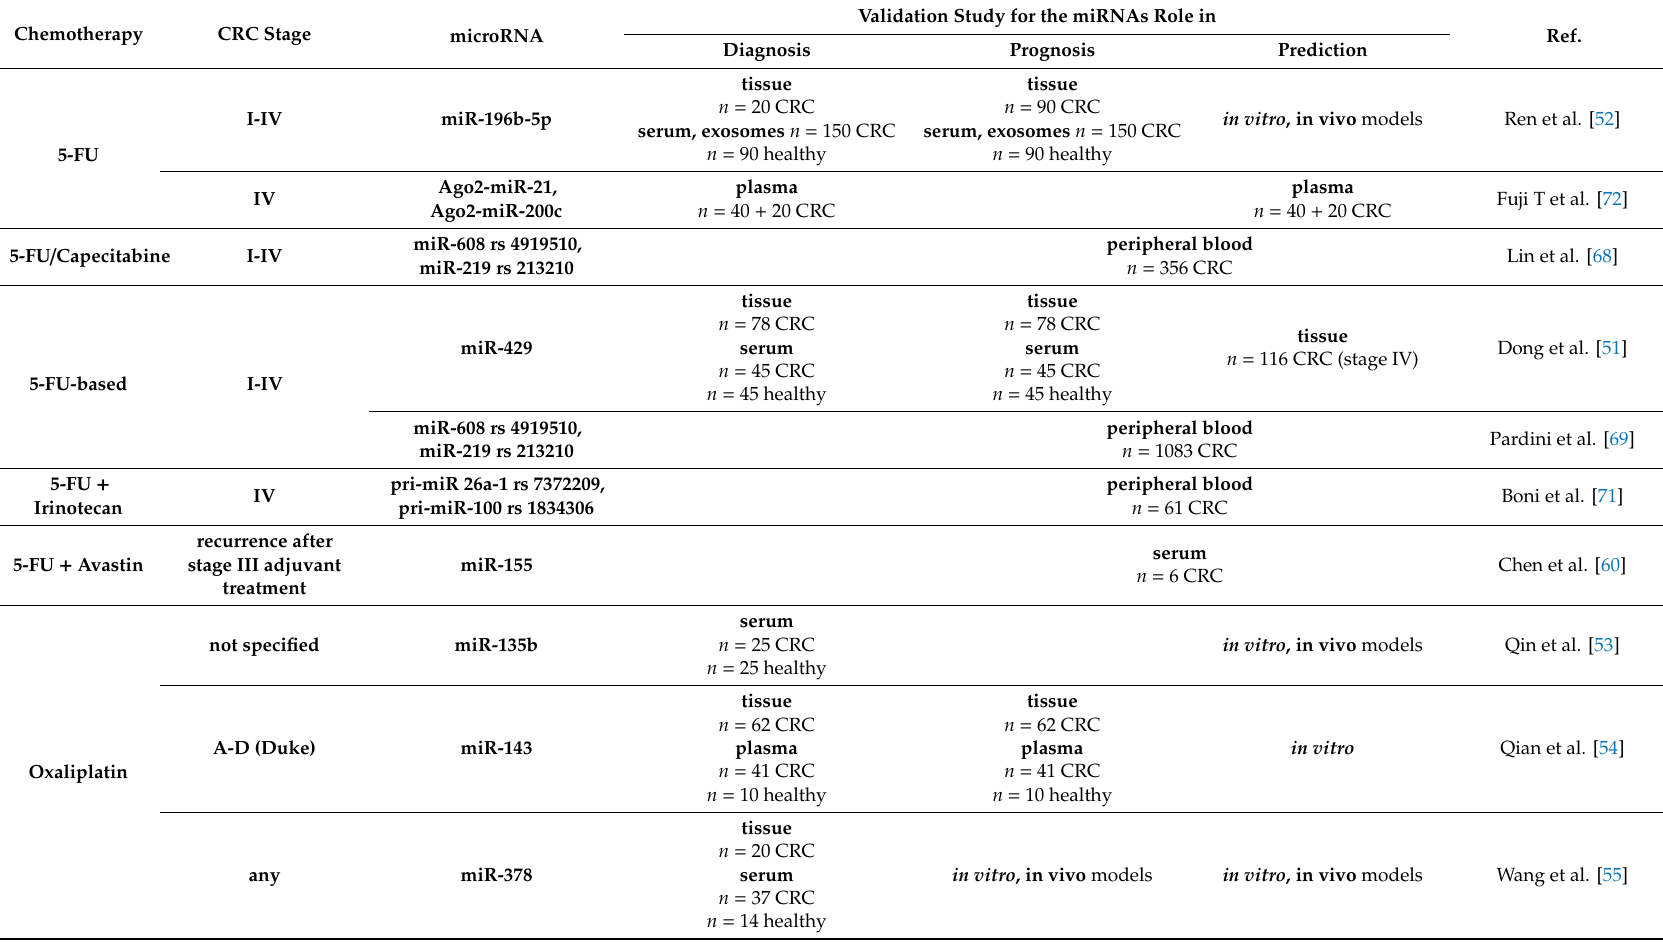
Table 2. Studies for predictive microRNAs (miRNAs) associated to systemic treatments response in colorectal cancer